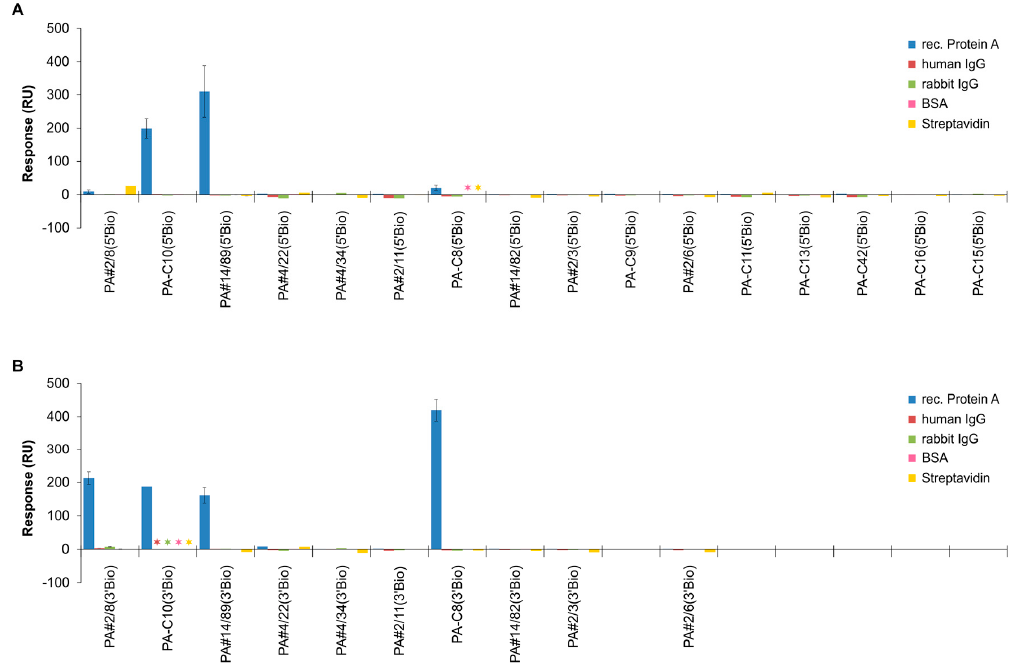
Figure 5. Representative sequences of the 15 identified groups from the NGS pool were screened for their individual binding abilities to Protein A. Comparative SPR-based interaction analyses were performed with the Biacore X100 instrument. Biotinylated aptamers were immobilized via the 5 ′ -end ( A ) or 3 ′ -end ( B ) on the streptavidin-modified sensor surface and 1000 nM Protein A was injected for binding. The sensor responses from the end of the binding phases (after 300 s) are shown. In addition, cross-specificities to other proteins were analyzed. Asterisks indicate if certain interactions have not been investigated.